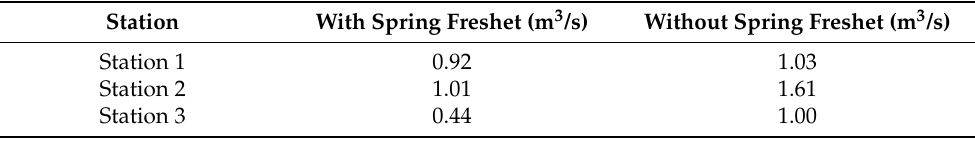
Figure 4. The performance of the drainage flow rate model during training and testing for the three stations. ( a ) Station 1 with training set from 1995–2013; ( b ) Station 2 with training set from 1996–2013; ( c ) Station 3 with training set from 1992–2013. Table 8. The root mean square error as the metric in evaluation of the flow rate